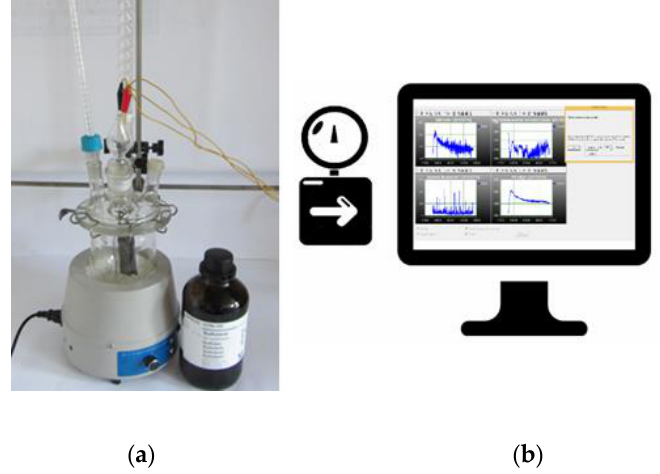
Figure 2. The laboratory-scale setup for ( a ) sulfolane corrosivity evaluation with ( b ) the corrosion data logger system.